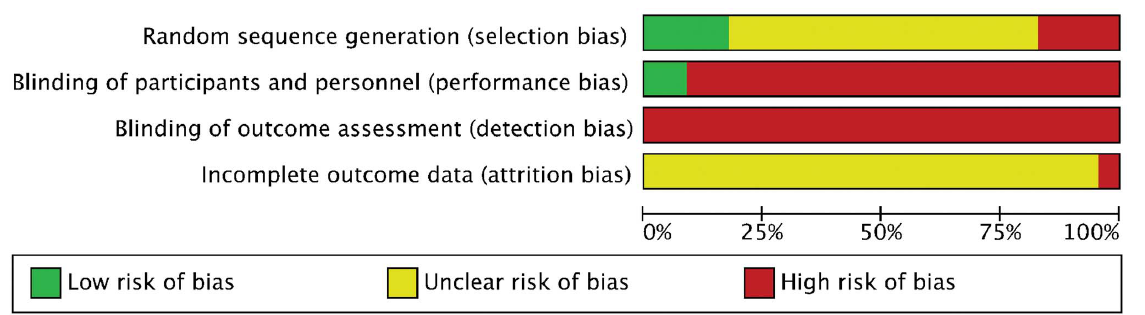
Figure 2. Risk of bias summary.